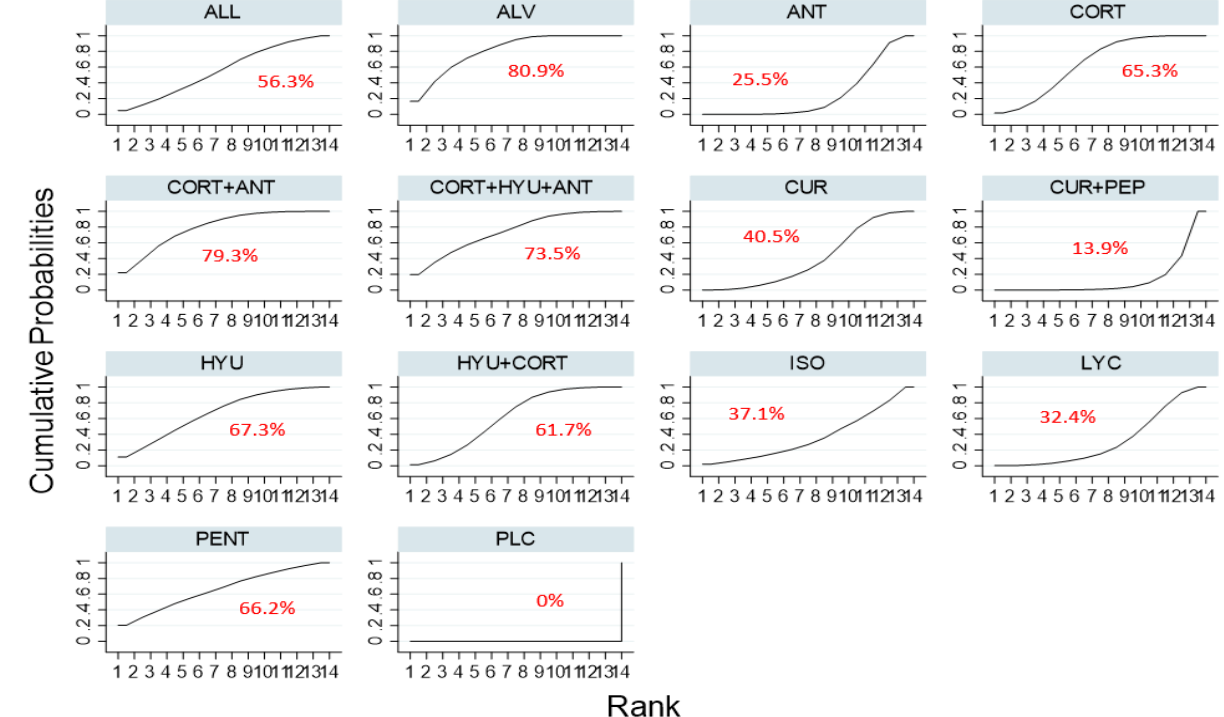
Figure 5. Network plot comparing the comparative efficacy of interventions used in the manage- ment of OSMF (burning sensation). Abbreviations: HYU — hyaluronidase; CORT — corticosteroid; LYC — lycopene; ALL — allicin; ANT — antioxidant; CUR — curcumin; ALV — aloe vera; PEP — piper-